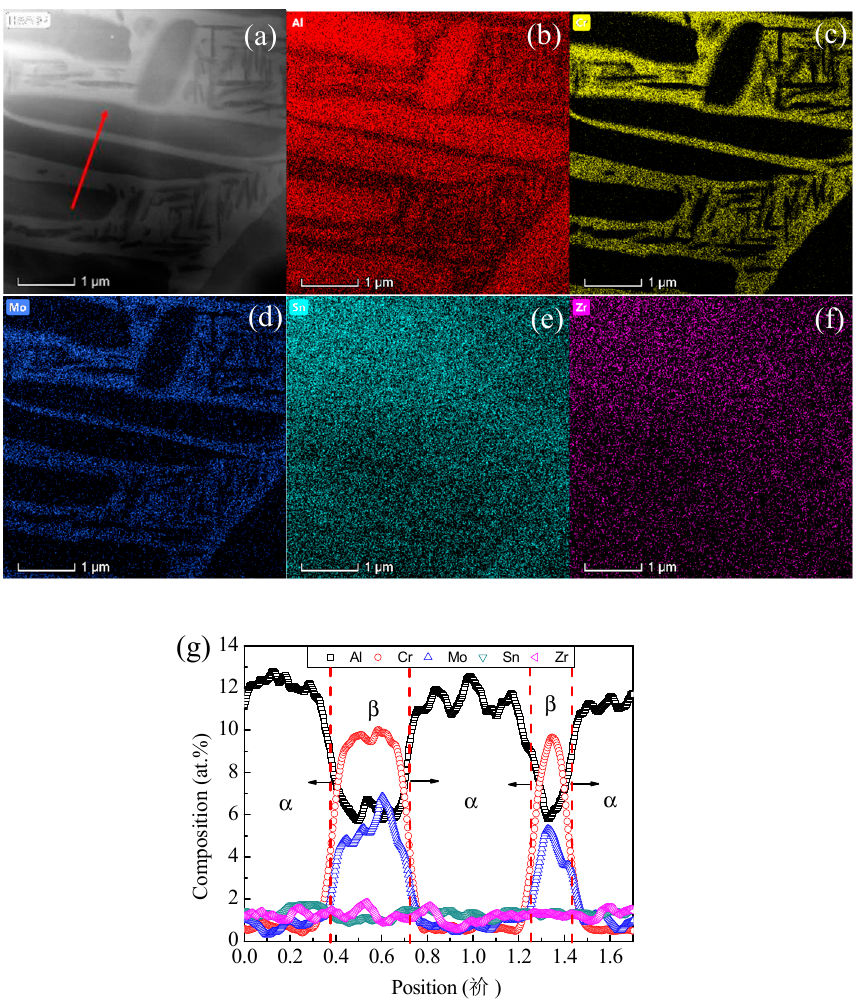
Figure 5. Microstructure and local composition mapping in the sample heated to 933 K: ( a ) HAADF (high-angle annular dark field image), ( b ) Al, ( c ) Cr, ( d ) Mo, ( e ) Sn, ( f ) Zr, and ( g ) composition profiles along the red line in (a).